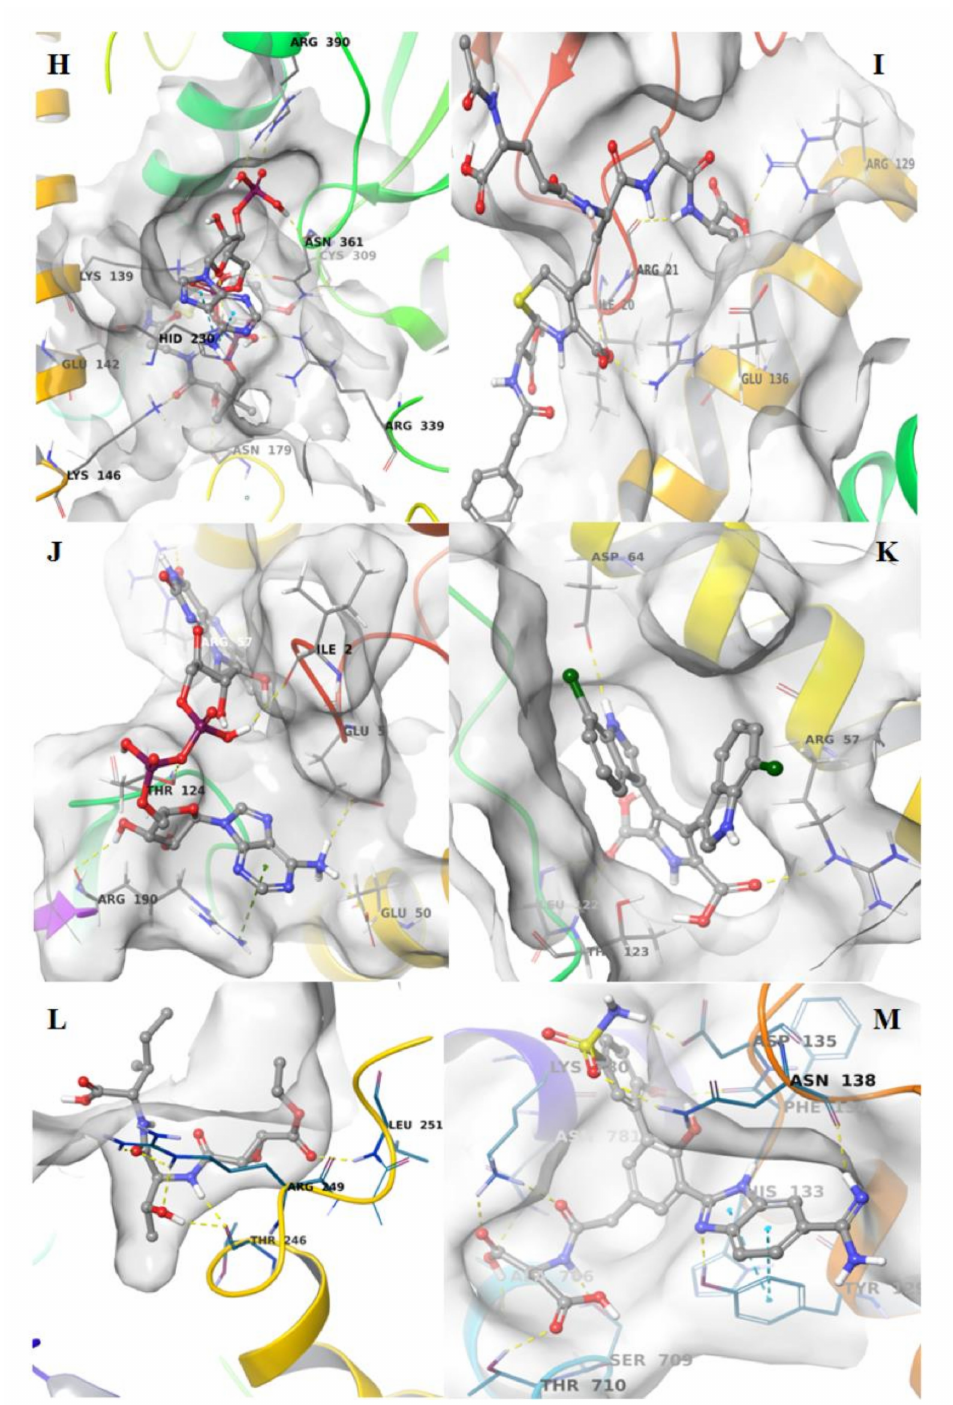
Figure 4. ( A ) DB08239 binding pose in 3C-like protease; ( B ) DB07358 binding pose in papain-like protease; ( C ) DB02933 binding pose in guanine-N7-methyltransferase (nsp14); ( D ) DB01792 binding pose in NendoU / nsp15; ( E ) DB01859 binding pose in nsp16; ( F ) synapoylCoenzyme A binding pose in nsp4; ( G ) DB02794 binding pose in nsp9.( H ) DB04579 binding pose in helicase, pocket A; ( I ) PCI-27483 binding pose in helicase, pocket B; ( J ) flavin-N7 protonated-adenine dinucleotide binding pose in nsp7-8, pocket A; ( K ) DB06955 binding pocket in nsp7-8, pocket B; ( L ) DB04579 binding pose in nsp7-8–12, pocket A; ( M ) PCI-27483 in nsp7-8–12, pocket